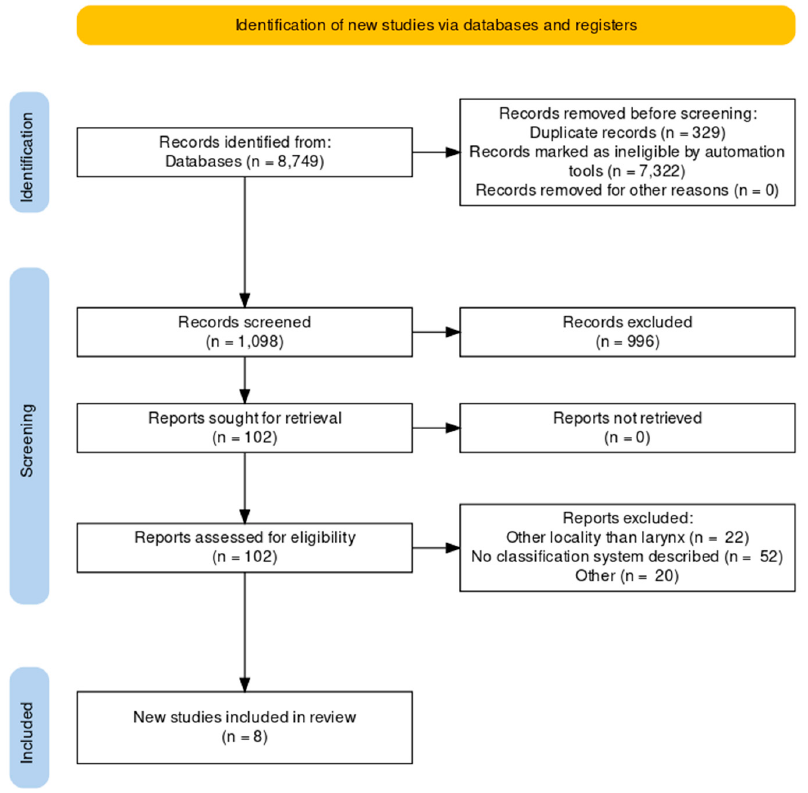
Figure 1. PRISMA flow diagram of the selection process of the relevant articles .